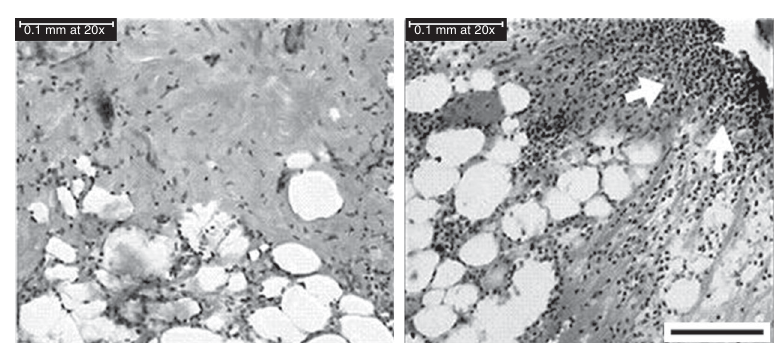
Figure 3. Photomicrography of the skin wound in the dexamethasone (A) and dexametha- sone + laser groups (B) at 24 h. The white arrows point to increased cellularity with the intense presence of mononuclear cells in the infiltrate, predominantly fibroblasts and neutrophils in the skin wound margins (H&E; scale bar: 0.1 mm at 20X).